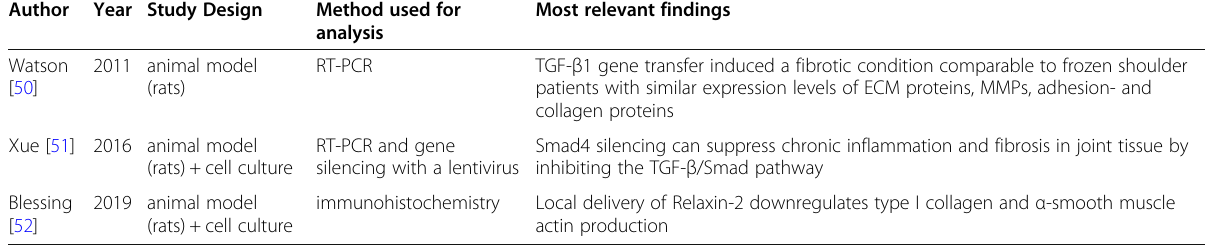
Table 3 Animal studies; animal studies with the specific aim to investigate the pathophysiology of frozen shoulder Author Year Study